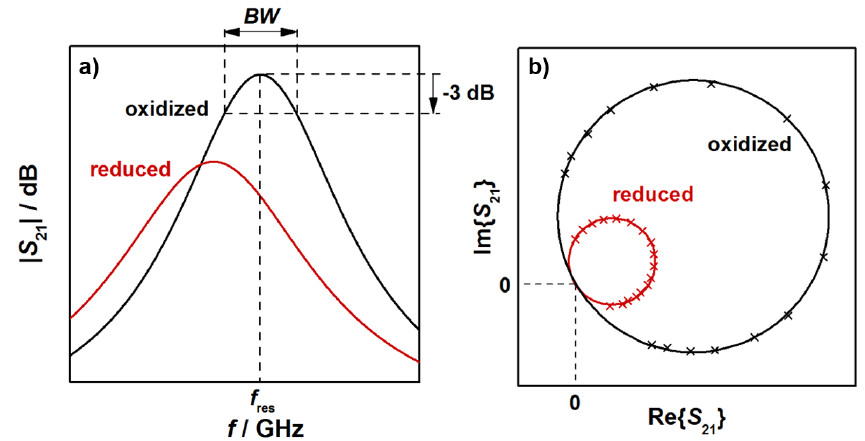
Figure 2. ( a ) Transmission parameter S 21 and ( b ) complex spectrum of the TE 111 mode for an oxidized and a reduced three-way catalyst.